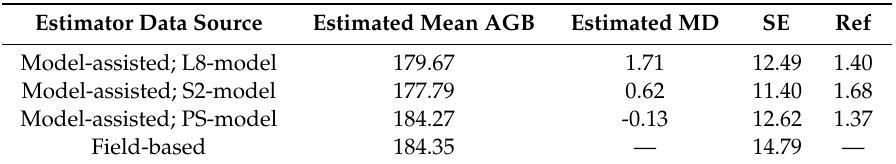
Table 6. Estimated mean AGB (Mg ha − 1 ), mean deviation (MD) in Mg ha − 1 , standard error (SE) of the mean estimates (Mg ha − 1 ) and relative e ffi ciency (REf) when using the selected models to assist in the estimation.